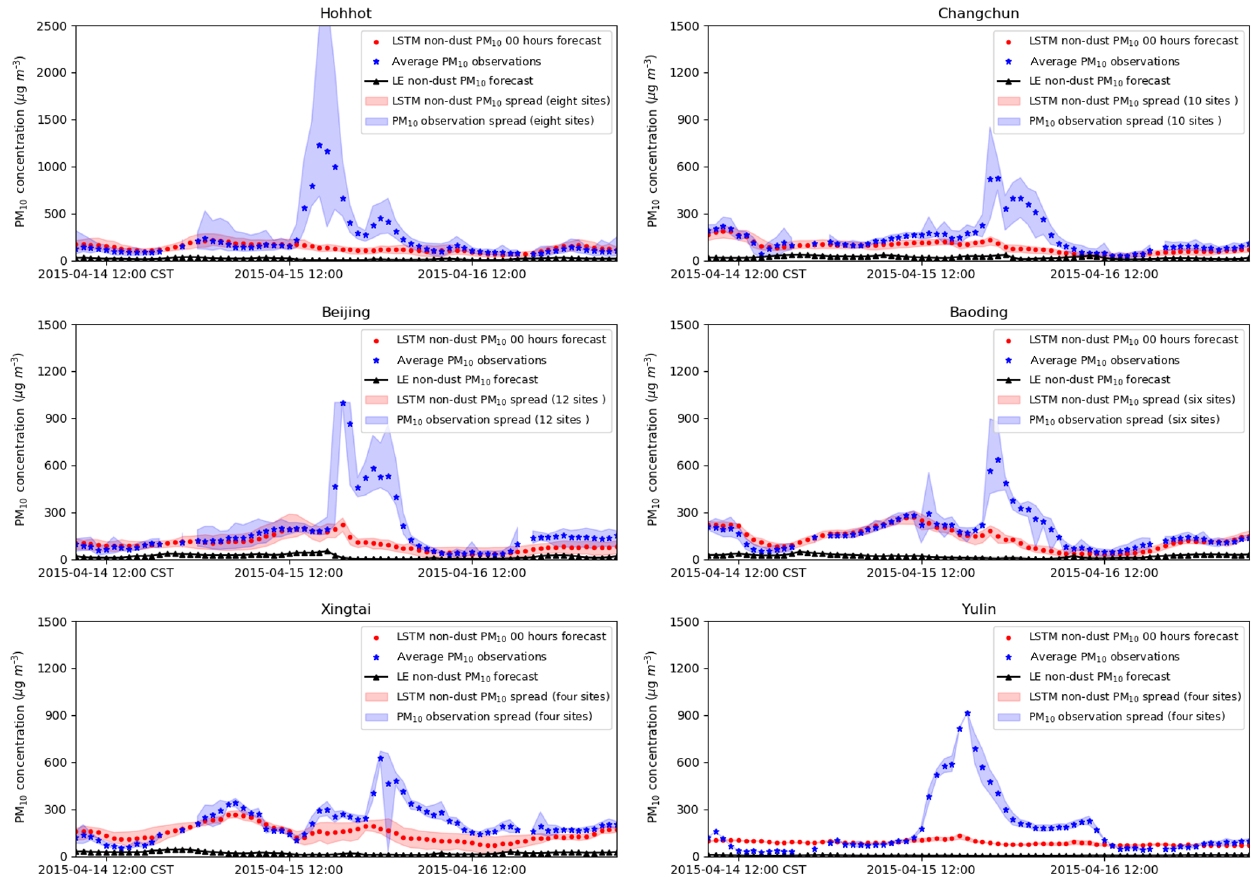
Figure 5. Time series of PM 10 measurements and LOTOS-EUROS/non-dust- and LSTM-predicted PM 10 levels at six cities: Hohhot, Changchun, Beijing, Baoding, Xingtai, and Yulin. LE: LOTOS-EUROS; LSTM: long short-term